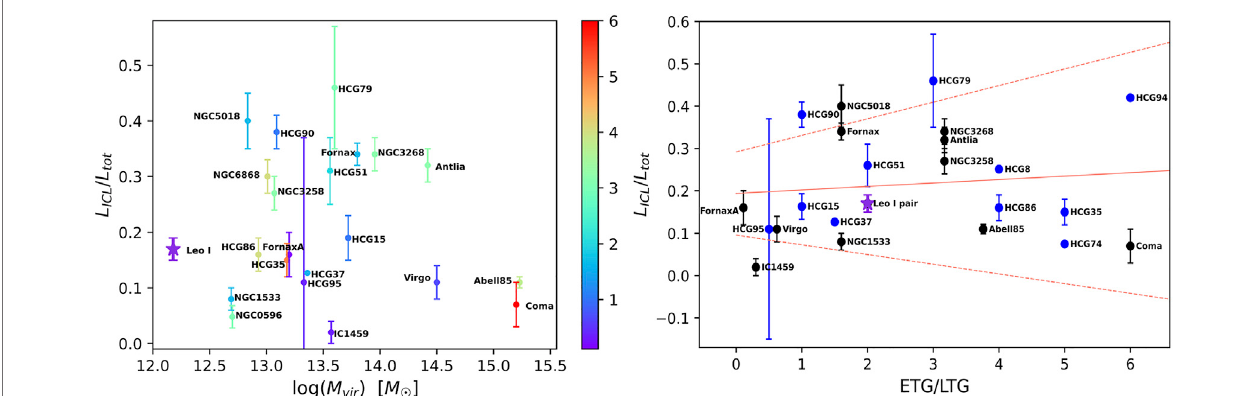
FIGURE 9 | Left panel: Luminosity ofthe diffuse light component normalised to the total luminosity of the environment (group or cluster of galaxies) as afunction of the virial mass. The value derived for LEO I pair is compared with those for several compact groups, taken from Da Rocha et al. (Da Rocha et al., 2008), Selim and Iqbal (SelimandIqbal,2008),Pildisetal.(Pildisetal.,1995),Poliakovetal.(Poliakovetal.,2021).TheestimateforHCG94andHCG37areprovidedbyPildisetal.(Pildisetal., 1995) and Poliakov et al. (Poliakov et al., 2021) without an error range, respectively. In addition, values for the IGL estimated for other groups of galaxies derived using VEGAS data are also shown. These are: NGC 5018 group (Spavone et al., 2018), NGC 1533 triplet, IC 1459 group (Iodice et al., 2020), Fornax A subgroup (Raj et al., 2020), HCG 86 (Ragusa et al., 2021), and NGC 6868, NGC 3258,NGC 3,268, NGC 0596 (Ragusa et al., 2021; in preparation). The ICL fraction for the Fornax clusterisderivedbySpavoneetal.(Spavoneetal.,2020)usingFDSdata.WealsoreportthevaluesforVirgo(Mihosetal.,2017),Coma(Jiménez-Tejaetal.,2019),Abell 85 clusters (Brough et al., 2017; Montes et al., 2021) and Antlia cluster (Ragusa et al., 2021; in preparation). Although these estimates are all obtained with the same approach,itmustbetakenintoaccountthatsomeofthemcomefromdifferentphotometricbands.ThecolorofeachpointiscodedaccordingtoitsETGs-to-LTGsratio. Itseems tosuggestthatnoevident trend existsbetweentheamountofIGL/ICL and M vir . Right panel: LuminosityoftheICL component normalised tothe totalcluster or groupluminosityasafunctionoftheETGs-to-LTGsratio.TheIGLforallHCGsavailableinliteraturearemarkedasbluepoints.Otherestimatesforgroupsandclustersof galaxiesareindicatedwiththeblackpoints. ThevaluefoundinthisworkforLEOIpair ismarkedwithpurple star-like point.Thecoralsolidlinecorrespondstothebest fi t for the linear correlation and the dashed corallines mark the 2 σ signi fi cance range ofthe correlation. The NGC 5018group and Fornaxcluster have an ETG-to-LTG ratio similar to the NGC 1533 group and HCG 37, but former contain about the double amount of IGL-ICL respect to teh latter. The same goes for Coma and HCG 94. In contrast, Virgo and Coma clusters share about the same amount of ICL, but the fi rst has a ETG-to-LTG ratio equal to 0.62, the second 10 times greater (ETG-to-LTG = 6).Thecoralsolidlinecorrespondstothebest fi tforthelinearcorrelationandthedashedcorallinesmarkthe2 σ signi fi cancerangeofthecorrelation.ThevaluesforHCG 74, HCG 8, HCG 37, and HCG 17 (the latter overlaps to HCG 86) are from Poliakov et al. (Poliakov et al.,